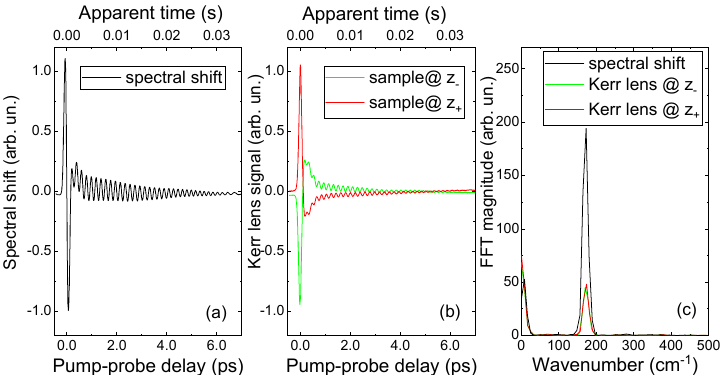
Figure 2. ISRS signals measured on CH 2 Br 2 at the sample positions corresponding to the maximum Raman signal intensities using: ( a ) spectral shift detection; ( b ) the Kerr lens detection system. ( c ) Fast Fourier transform of the oscillating regions of the signals, showing the Raman mode at 173 cm − 1 of the sample.